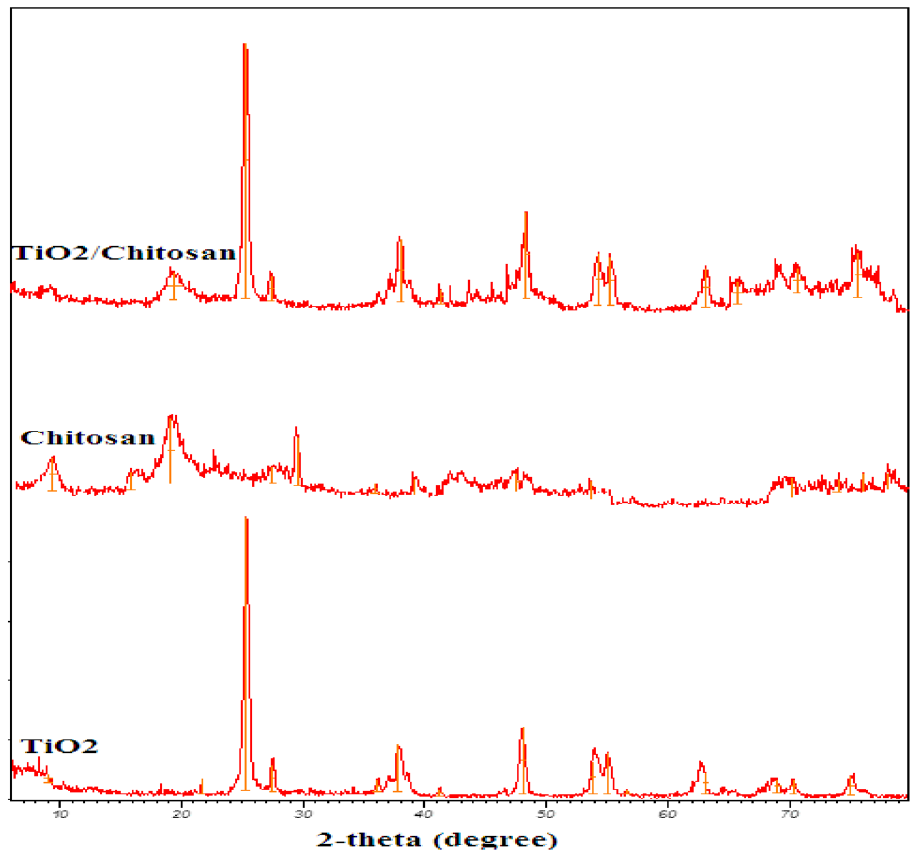
Figure 2. XRD patterns of TiO 2 , chitosan, and TiO 2 –chitosan